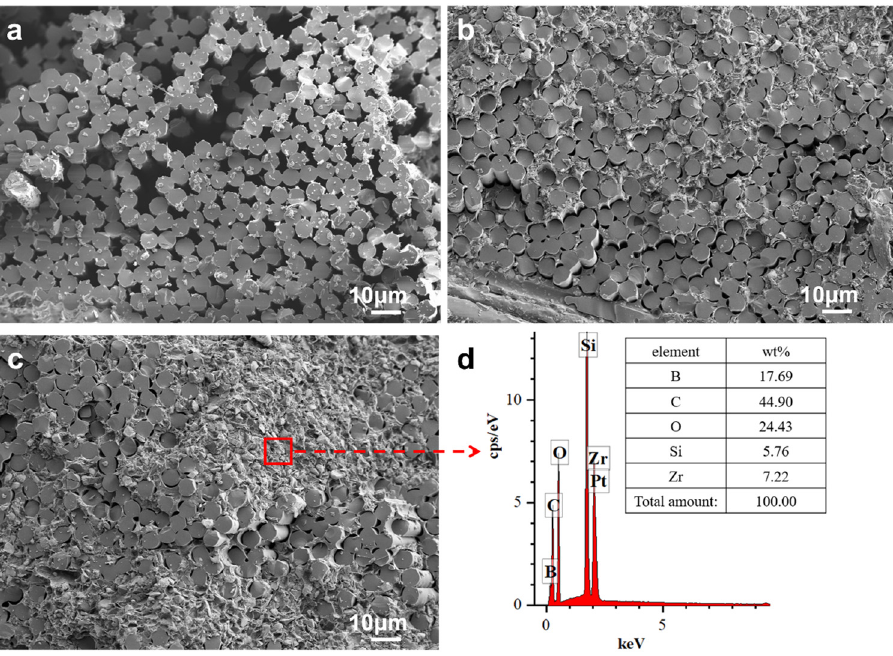
Figure 9: Cross - sectional micromorphology of heated composites. ( a ) Q – Ph - 4, ( b ) Z/Q – Ph - 4, ( c ) Z/Q – Ph - 8, and ( d ) ceramic layer EDS of Z/Q – Ph -